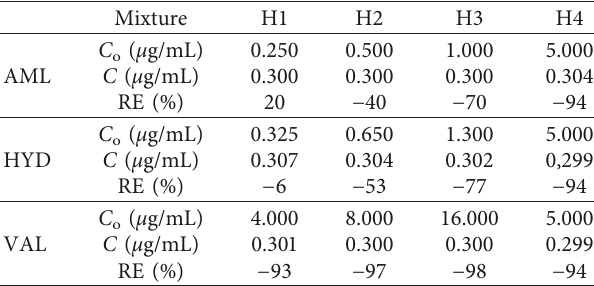
Figure 1: Analytical scheme. Table 1: Quantification results of AML, HYD, and VAL in a mixture using the Kalman filter with a random selection of initial guesses method.